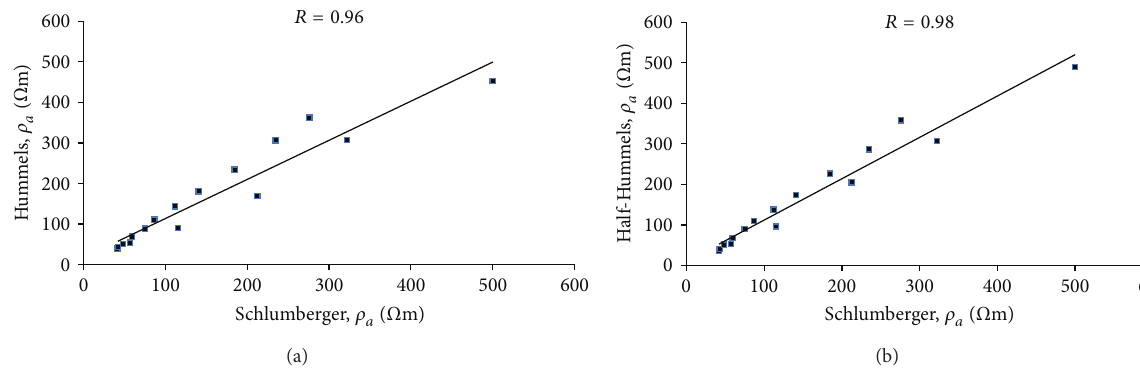
Figure 15: Statistical plot of apparent resistivity data for location 2 (banded gneiss) (a) Hummel against conventional Schlumberger (VES) and (b) “Half-Hummel” against conventional Schlumberger